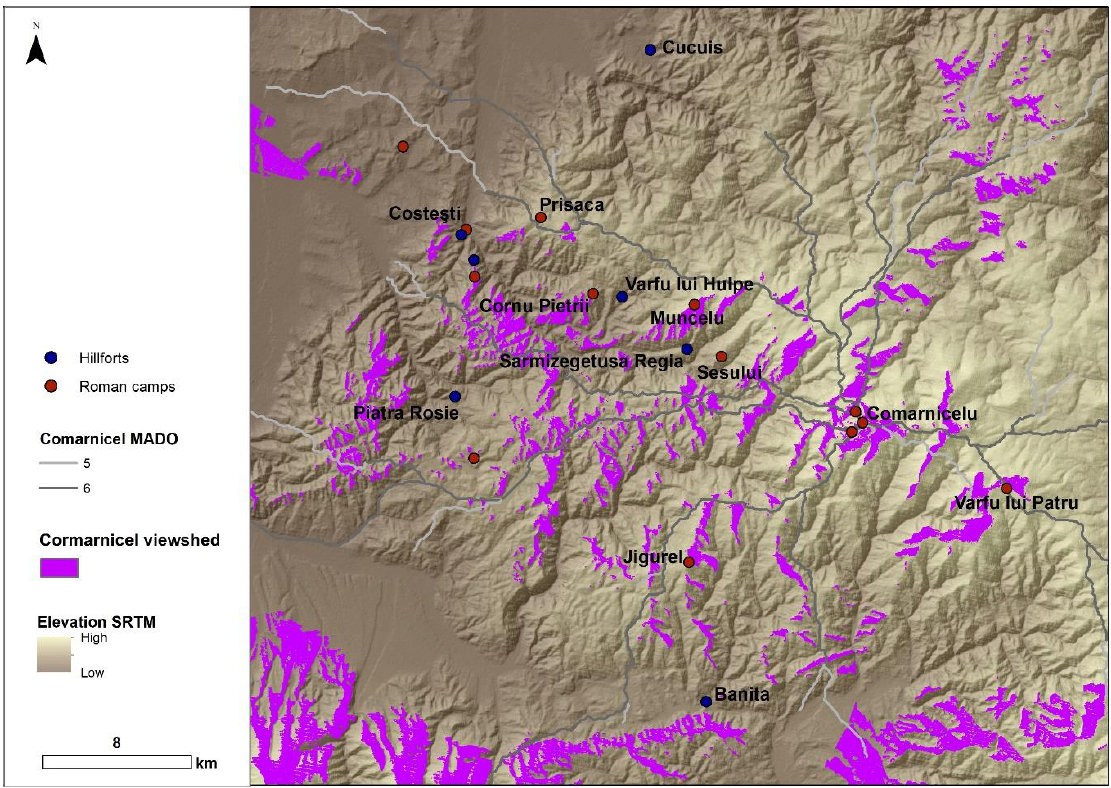
Figure 9. Visibility from Comărnicelu.